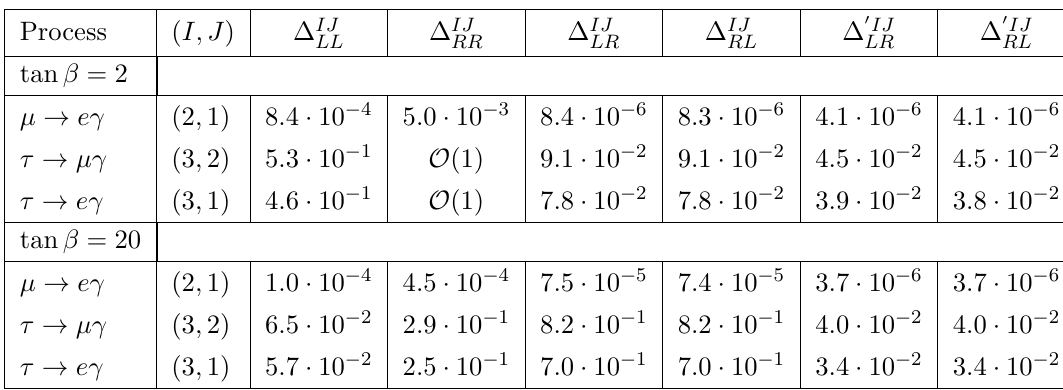
Table 3 . Upper bounds on the LFV parameters (cid:1) from radiative charged lepton decays for the MSSM spectrum de(cid:12)ned in eq. (5.3) and a SUSY scale of M = 400 GeV. All bounds scale (i.e. weaken) like M 2